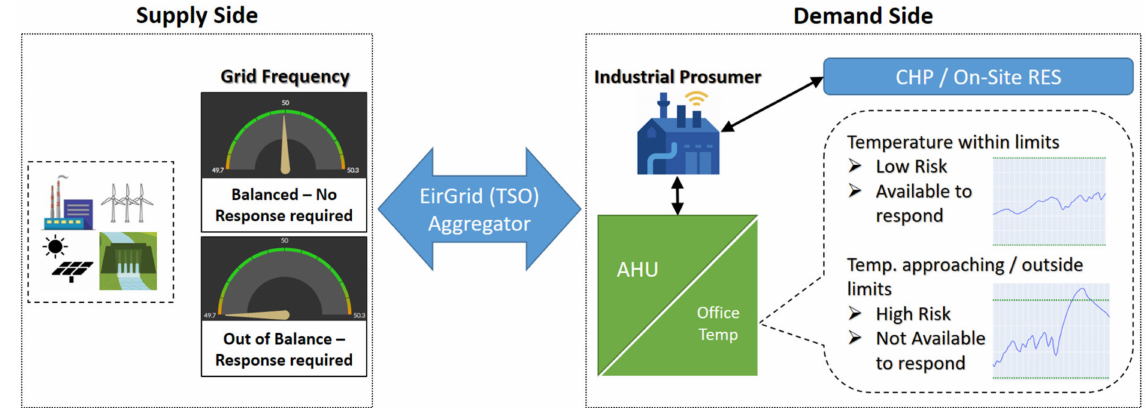
Figure 1. Overview of grid and building response